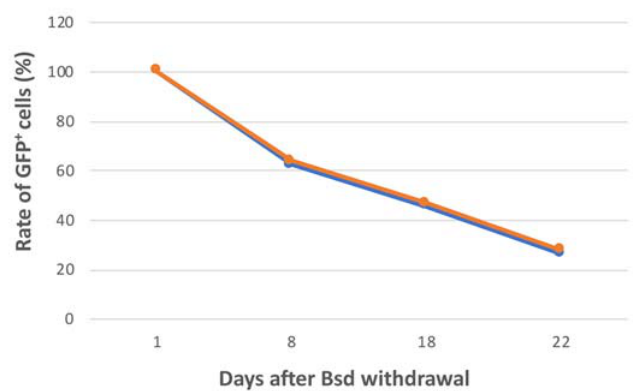
Figure 7. Loss of the HACs in the FVIII Y / - iPSC-HAC-FVIII clone 1 (orange line) and clone 2 (blue line) at the 8th, 18th, and 22nd day of culture after Bsd withdrawal, as quantitated by the fluorescence-activated cell sorting assay.